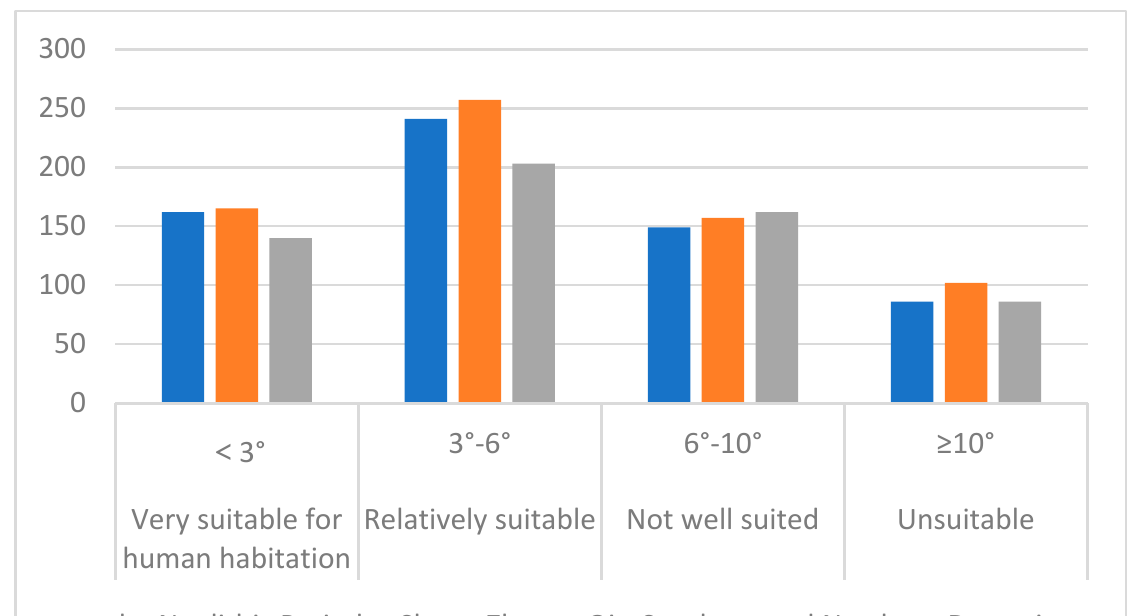
Figure 9. Elevation statistics of the distribution of settlements in different periods.